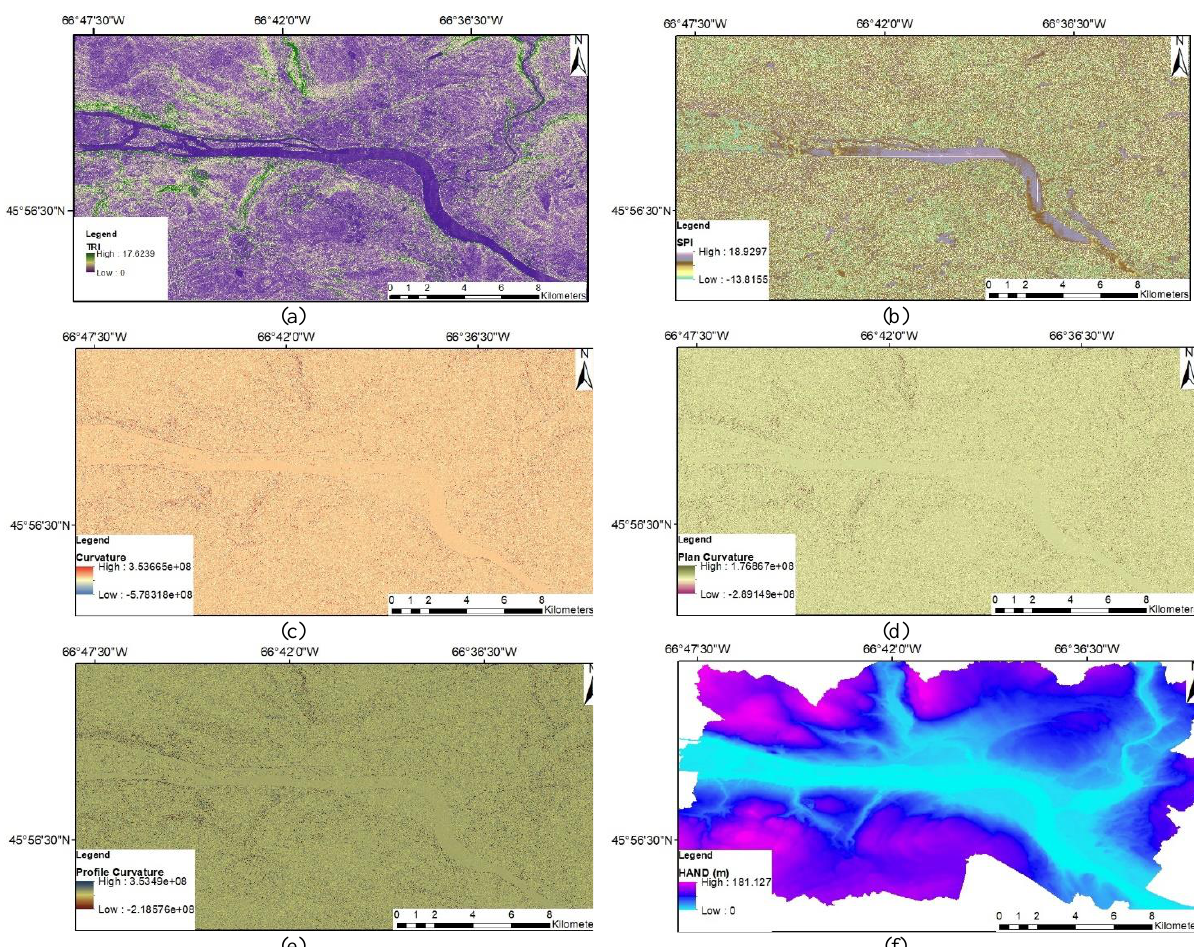
Figure 4. Conditioning factors used in the Random Forest classifier (part 2): (a) TRI (b) SPI (c) Curvature (d) Plan curvature (e) Profile curvature (f) HAND